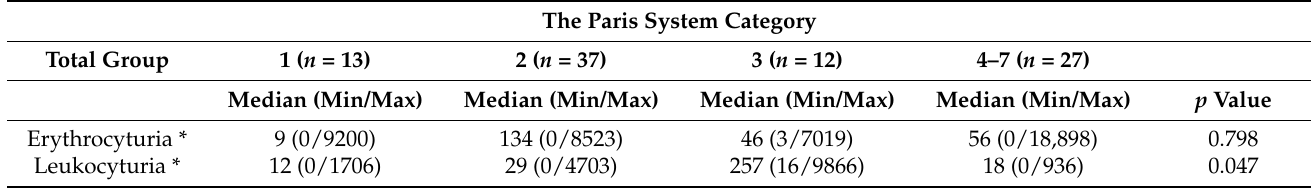
Figure 3. The effect of degree of leukocyturia on the frequency of atypical findings in cytology. Table 6. Effect of erythrocyturia and leukocyturia on The Paris System.